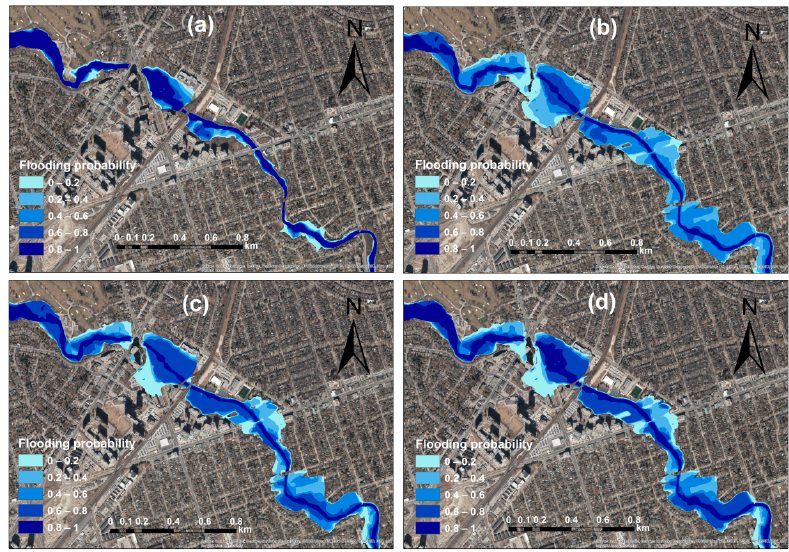
Figure 7. Probabilistic floodplain maps under future climate change from different data source for one downstream location: ( a ) current period; ( b ) 2040–2069 under RCP8.5 from CCDP; ( c ) 2030–2070 under RCP.8.5 from stationary IDF; and ( d ) 2030–2070 under RCP8.5 from non-stationary IDF.